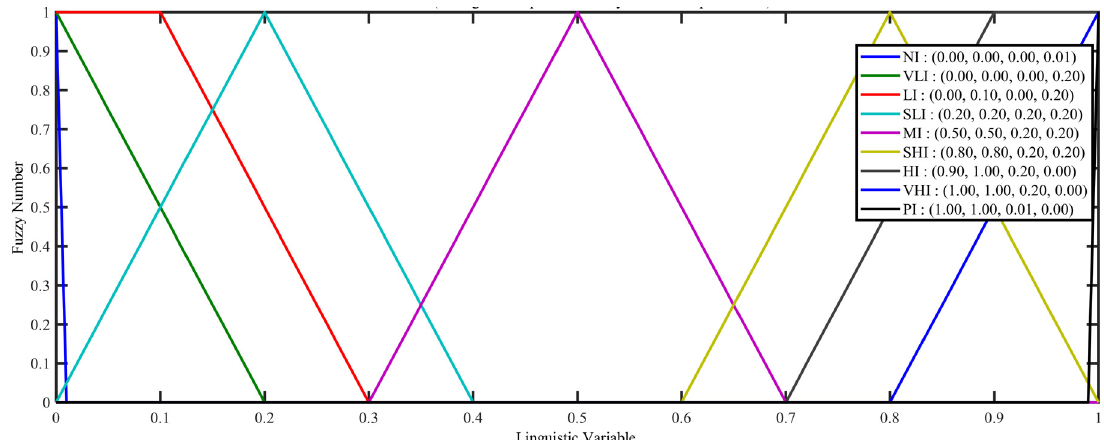
Figure 2. Trapezoidal-triangular fuzzy membership functions of linguistic variables. No importance (NI), very low importance (VLI), low importance (LI), slightly low importance (SLI), moderate importance (MI), slightly high importance (SHI), high importance (HI), very high importance (VHI), and perfect importance (PI).